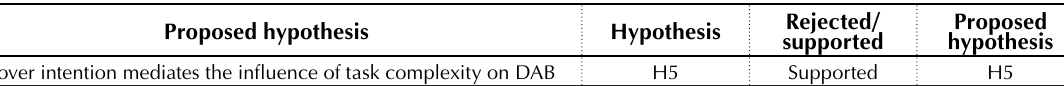
Table 6. Path coefficient of turnover intention between task complexity and dysfunctional auditor behavior